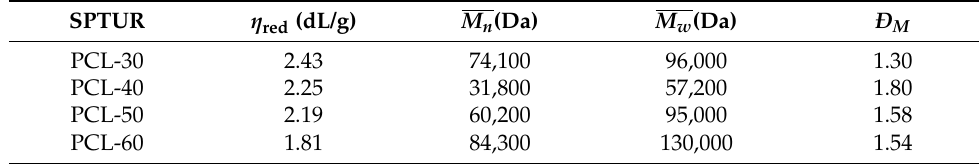
Table 2. η red values and GPC data of the SPTURs.